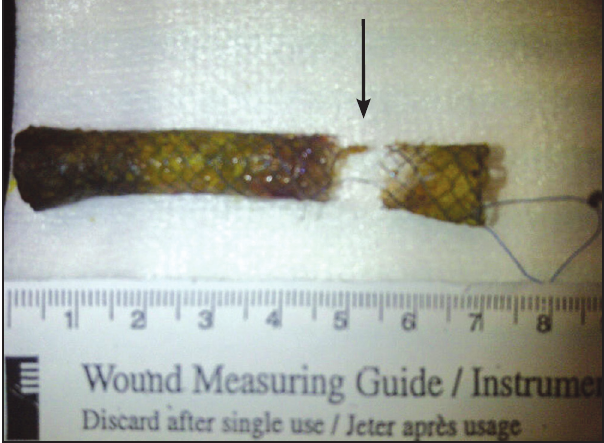
Figure 1) Covered self-expandable biliary metal stent after removal. The arrow indicates the fracture site